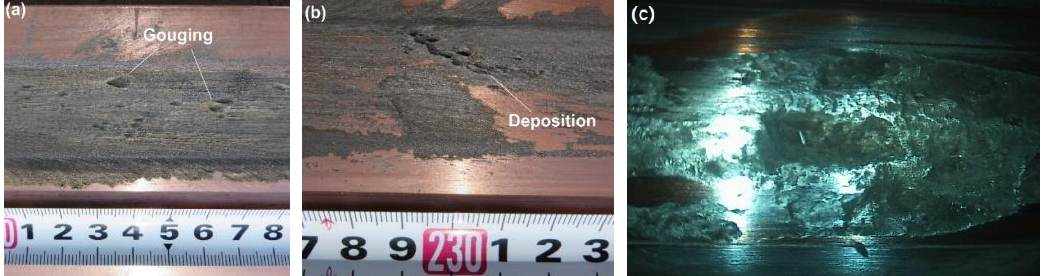
Figure 1. The appearance of the rail’s surface. (a) Gouging. (b) The deposition on the rail surface. (c) The complex inner bore surface.